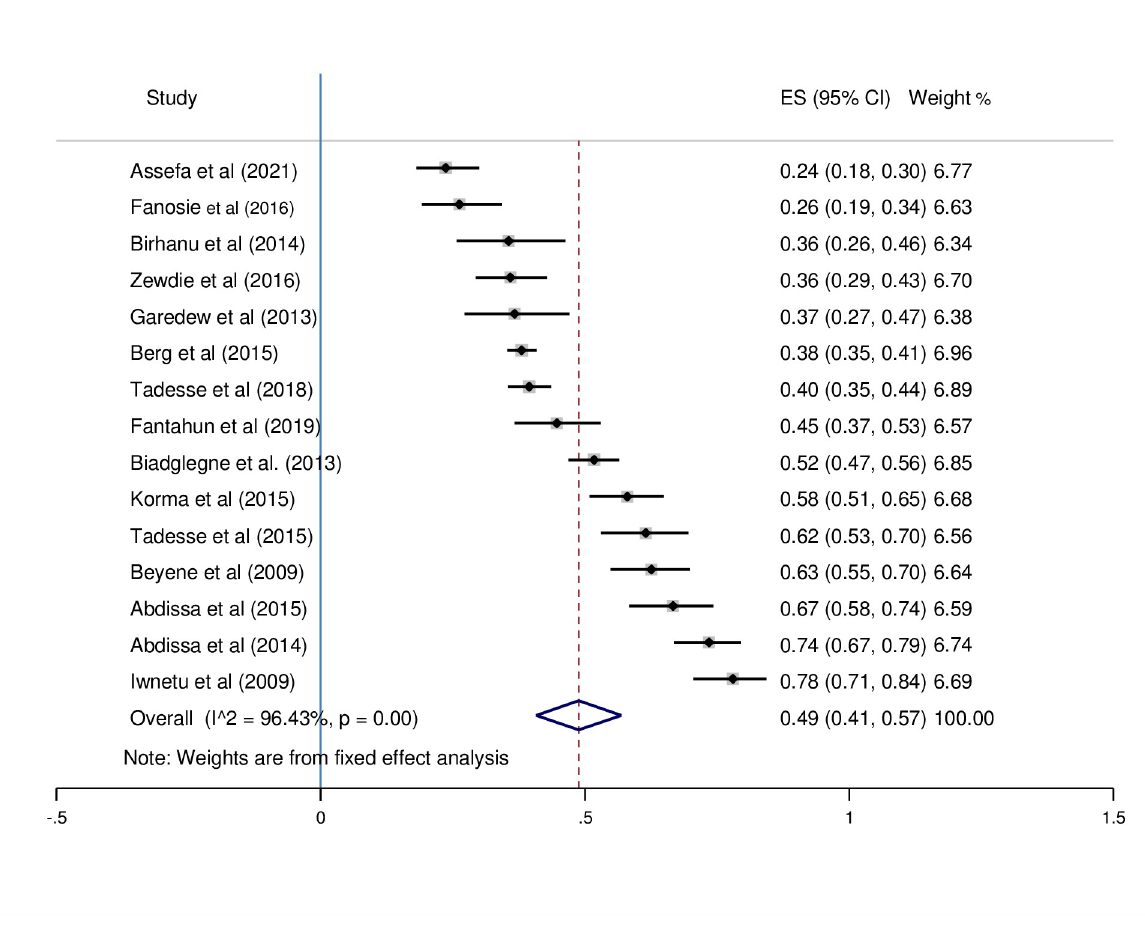
Fig 4. Pooled proportion of culture-positive EPTB using a fixed-effects